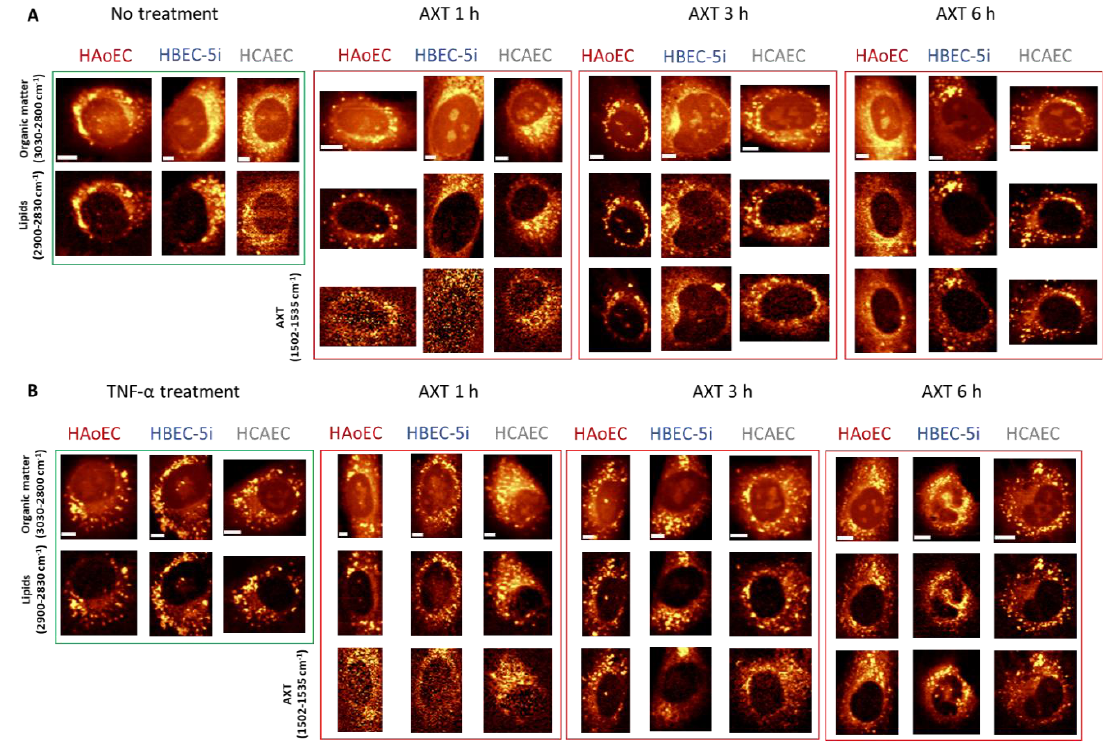
Figure 4. Representative Raman images of non-treated ( A ) and TNF- α -stimulated ( B ) endothelial cells incubated with AXT for 1, 3 and 6 h. Raman images of endothelial cell lines HAoEC, HBEC-5i and HCAEC were obtained by the integration of Raman bands over the selected spectral regions: 3030–2830 cm − 1 (organic matter), 2900–2850 cm − 1 (lipids) and 1530–1500 cm − 1 (AXT). Scale bars equal 5 µm.